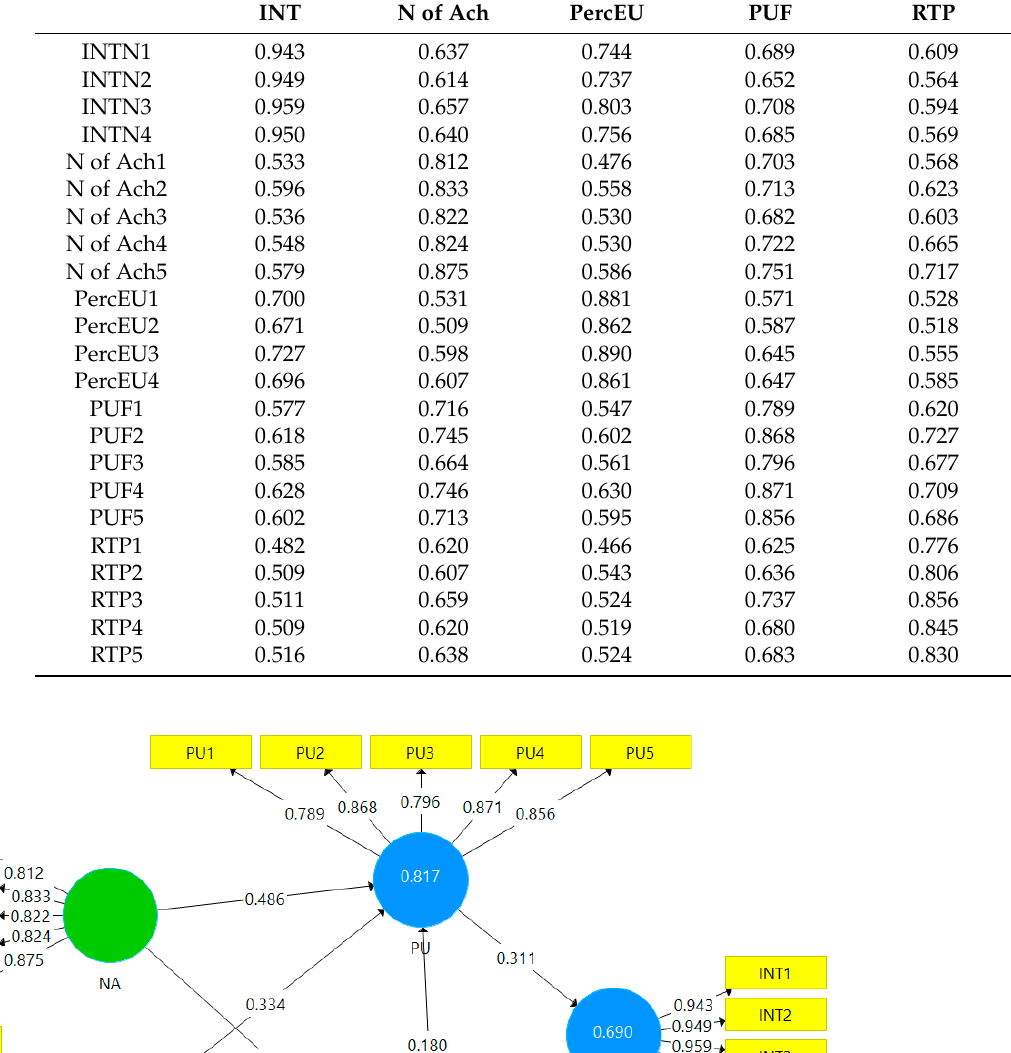
Table 2. Construct validity.